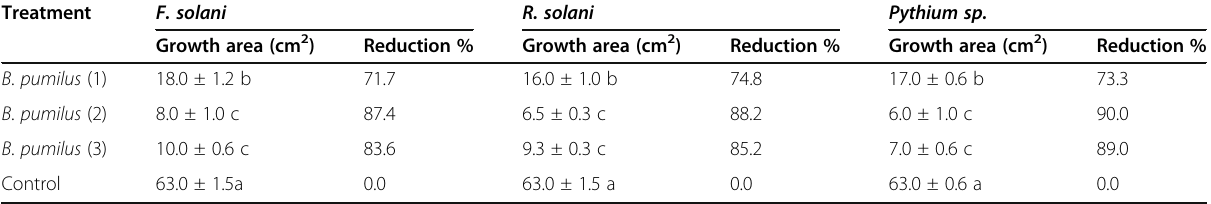
Table 1 Effect of three Bacillus pumilus isolates on growth area of strawberry black root rot disease under laboratory conditions Treatment